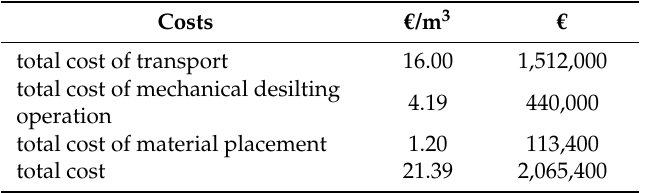
Table 8. Focus on the cost of nourishment by offshore sand evaluated for other Italian Regions. The order of magnitude is comparable to the cost of nourishment by reservoir